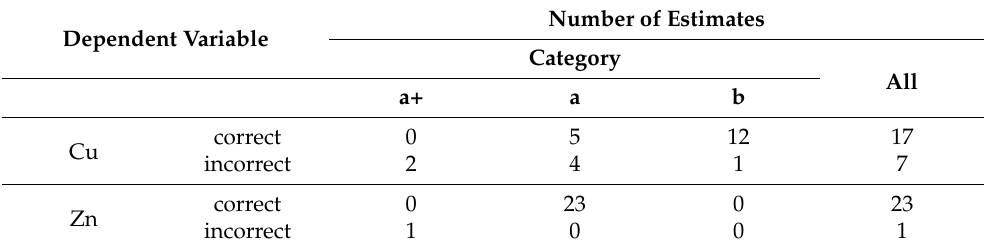
Table 6. Prediction of correctness for the teaching set.